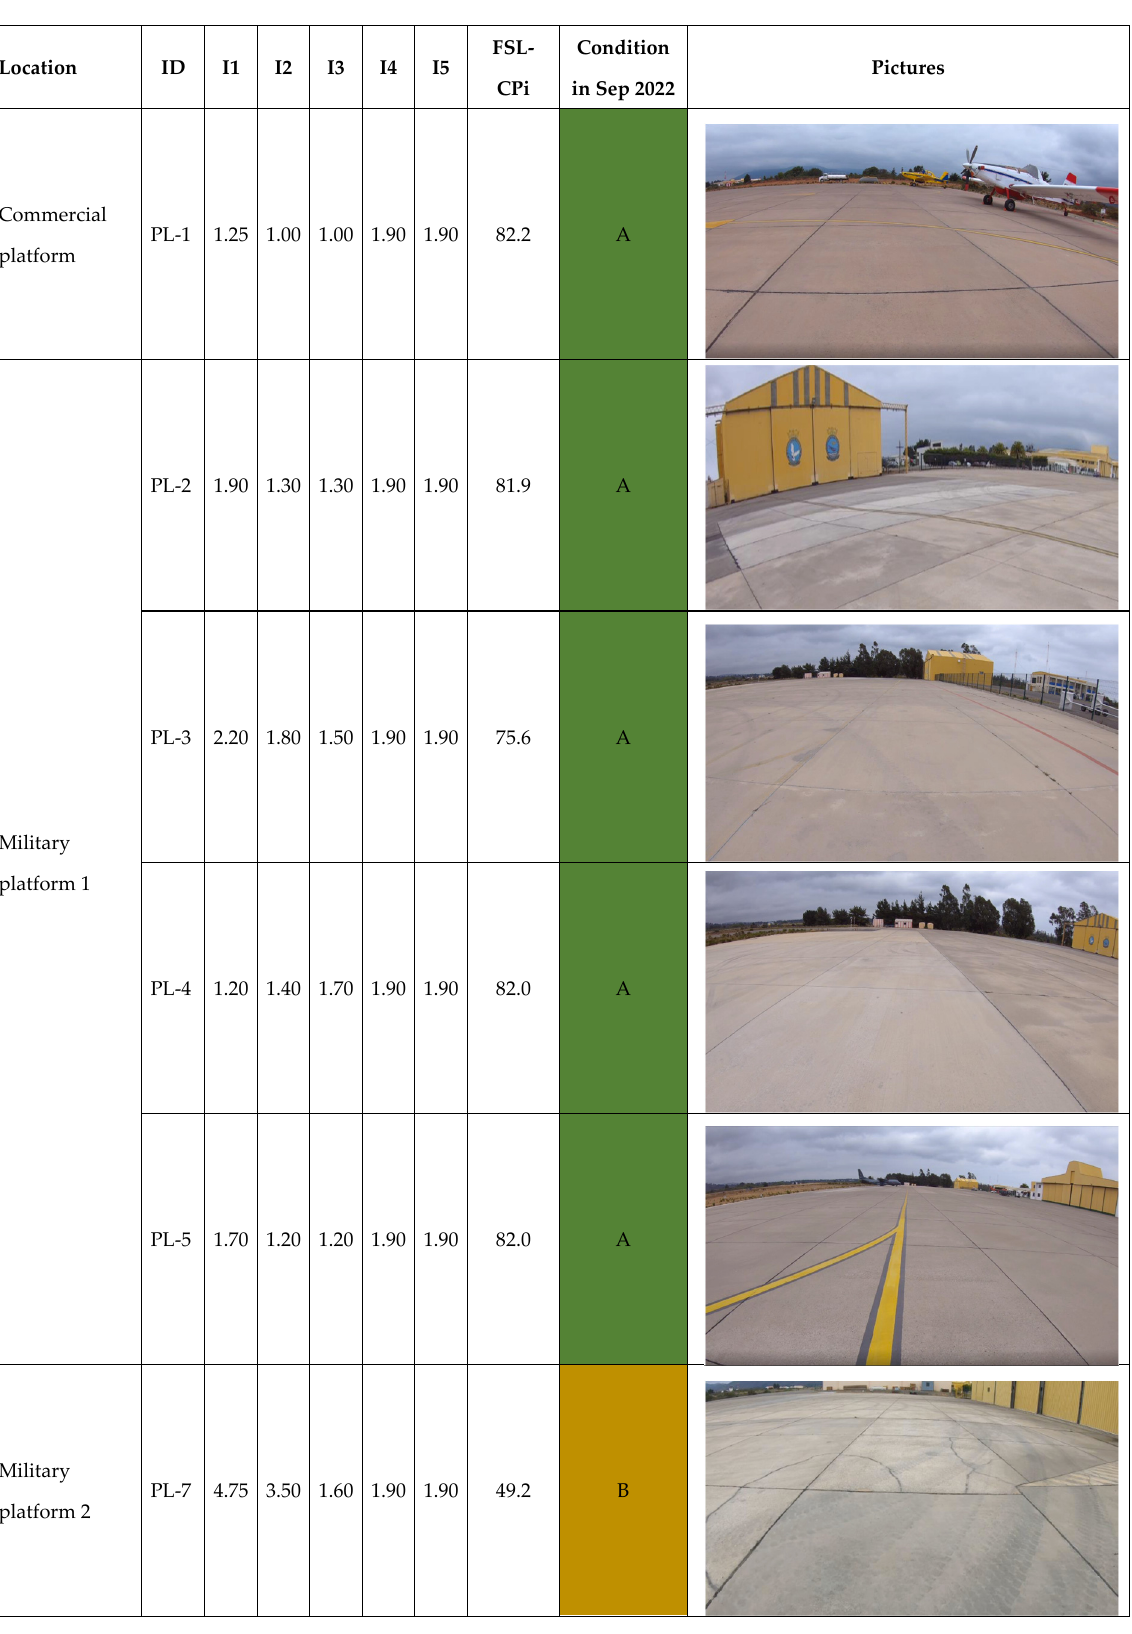
Figure 11. Application of the fuzzy logic system (FSL-CPi) to the concrete pavement case studies emplaced in the Viña del Mar Airport.